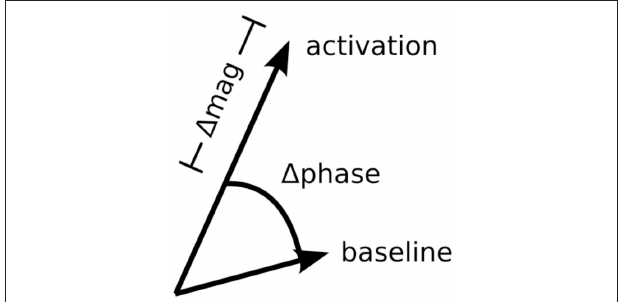
FIGURE 1 | Diagram of task-related phase and magnitude changes in the complex